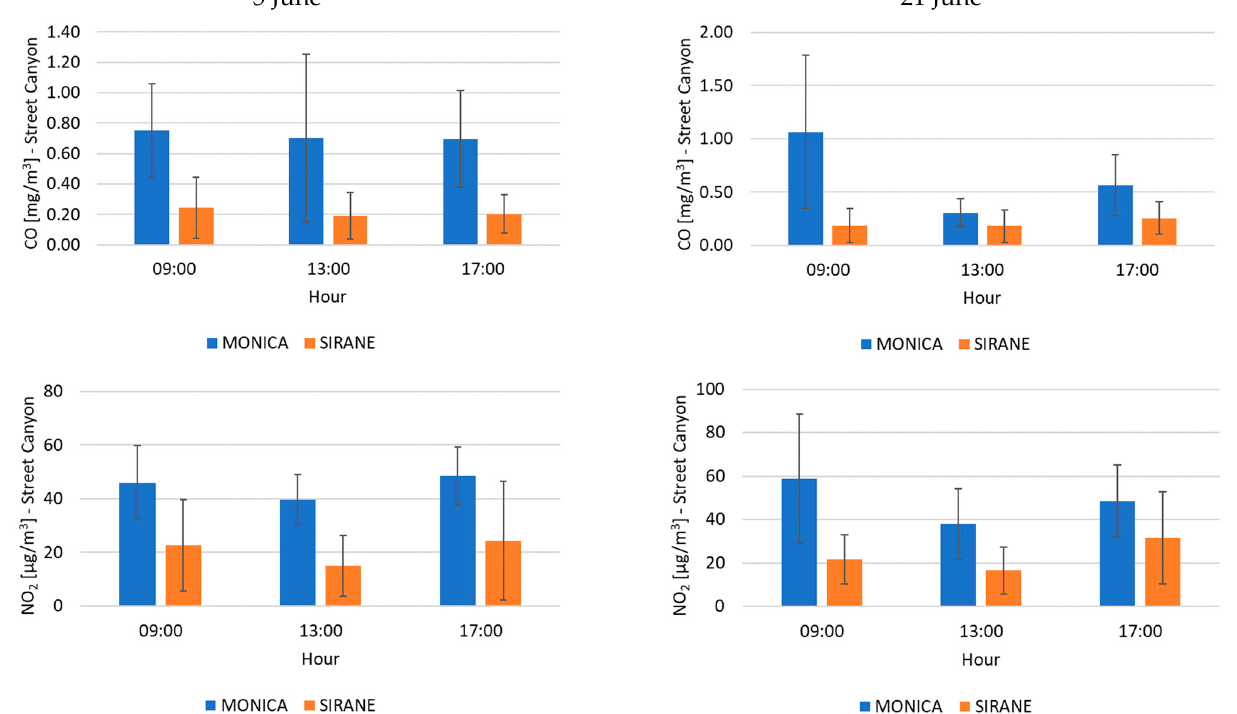
Figure 7. Comparison between the average measured and estimated concentrations of CO and NO 2 pollutants in relation to the street canyon segments.